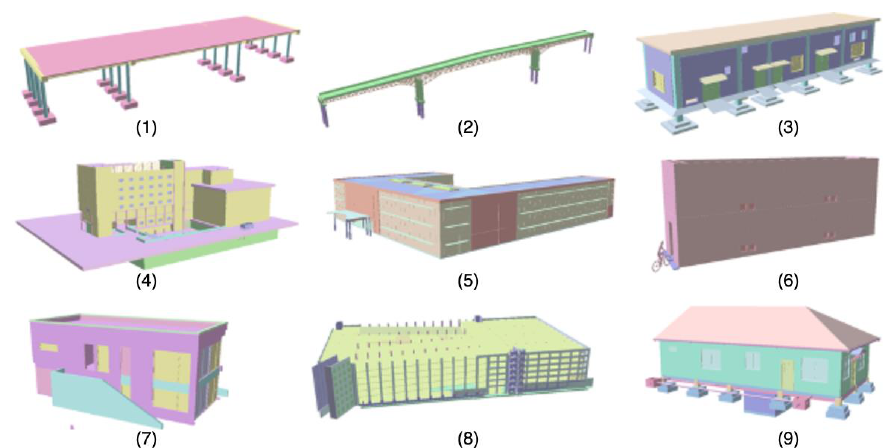
Figure 20. Additional models converted by